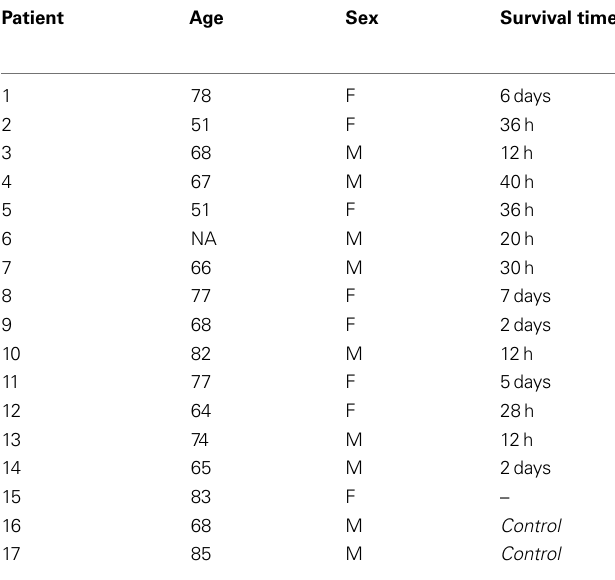
Table 1 | Case demographics of ischemic stroke patients and